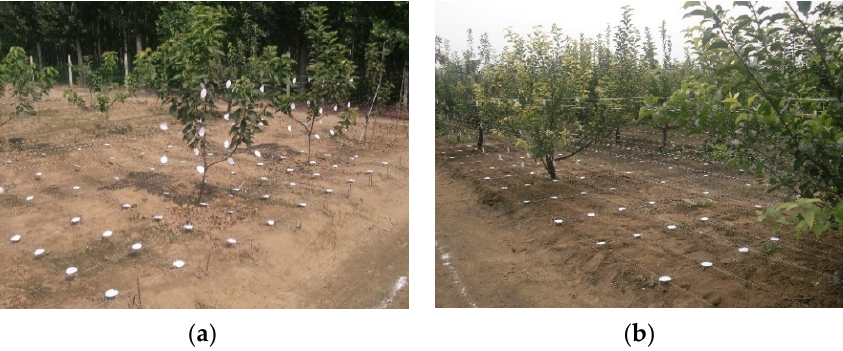
Figure 5. Experimental fruit trees: ( a ) Young cherry trees, ( b ) Adult apple trees. Table 1. Characteristics of the experimental fruit trees.